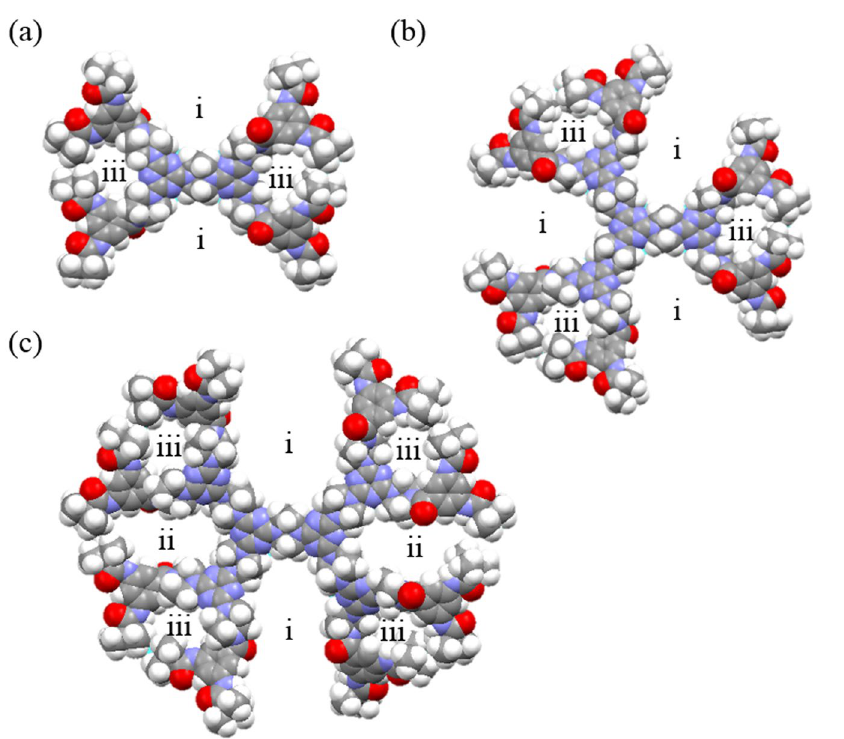
Figure 6. The equilibrium molecular conformations of ( a ) ( t - Bu - G 1 N ) 2 , ( b ) CC ( t - Bu - G 1 N ) 3 , ( c ) ( t - Bu - G 2 N ) 2 shown as space-fill models (N: purple, O: red, C: gray, H: white). Potential sorption sites are labelled with small Roman